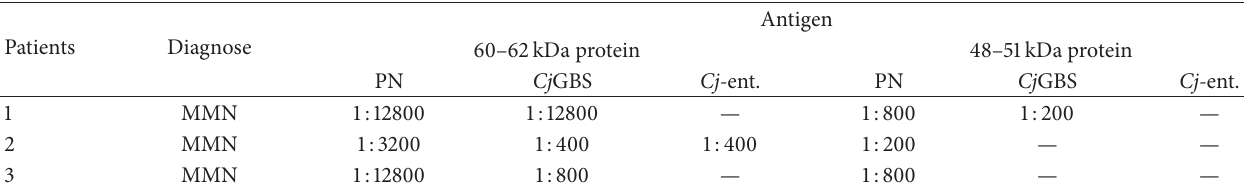
Table 3: Titer of IgG antibodies to purified glycoproteins from human peripheral nerve, Cj O:19-GBS, and Cj O:19-enteritis. Patients Diagnose